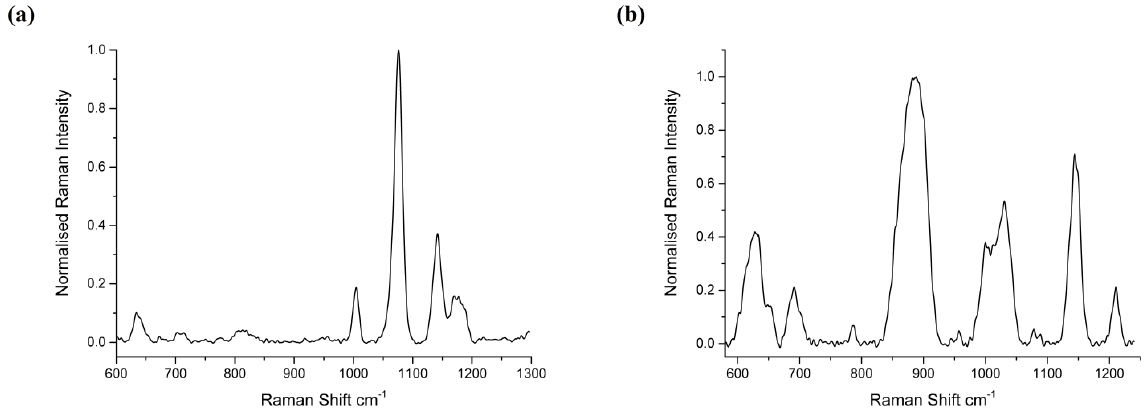
Figure 5. ( a ) 4-ATP Raman spectrum, on p53 bound substrate; ( b ) Raman spectrum of 6 Mercaptopurine (6MP) on EGFR bound substrate. For both spectra, 785 nm excitation and 25 point average was used.